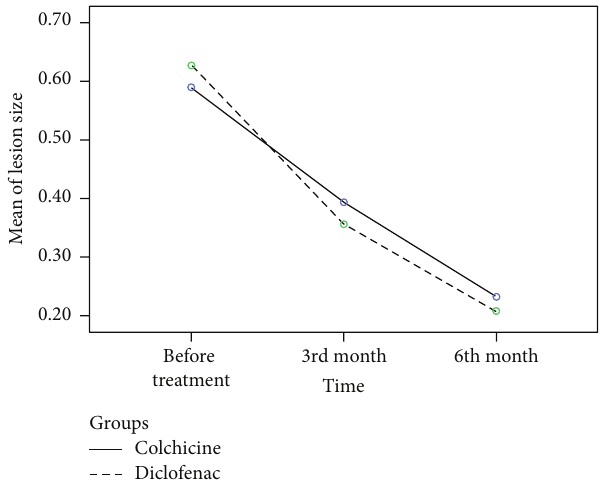
Figure 4: Mean of size of lesions: before and after the treatment. Covariates appearing in the model are evaluated at the following values: sex = 1.2128, age = 63.9362, and place =